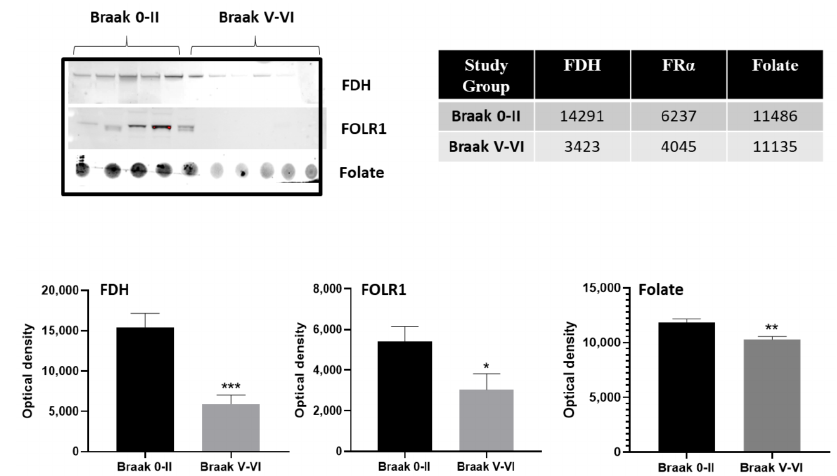
Figure 1. Western and dot blot analysis of CSF for FDH, FR α and folate. The images of the relevant bands and dots from different blots for FDH, FR α and folate are shown at top with optical density measurements plotted as mean ± SEM for n = 21 per group. *, ** and *** show significance at p < 0.05, 0.001, and 0.0001, respectively. The mean optical density measurements are shown in the table. Images of the full blot membranes are shown in Supplementary Figure